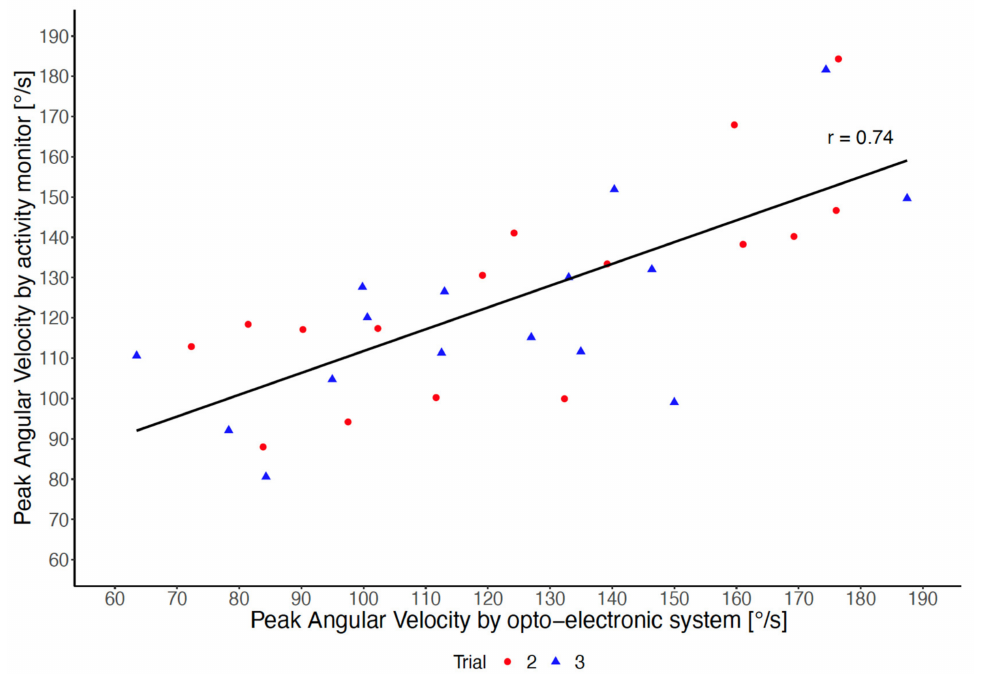
Figure 1. Association between peak angular velocity measured by the thigh-worn activity monitor and peak angular velocity measured by the opto-electronic system, according to Trials 2 and 3. The association between PAV measured by the thigh-worn activity monitor and peak power measured by force plates and the opto-electronic system was r = 0.76 corresponding to an adjusted R 2 of 0.56 (Figure 3). After adjusting angular velocity for body height, the adjusted R 2 increased. The respective linear regression model explained 73% of variance of peak power during the STS transfer and is shown in Equation (4). Further